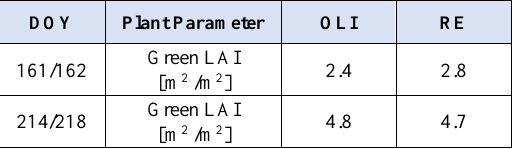
DOY Plant Parameter OLI